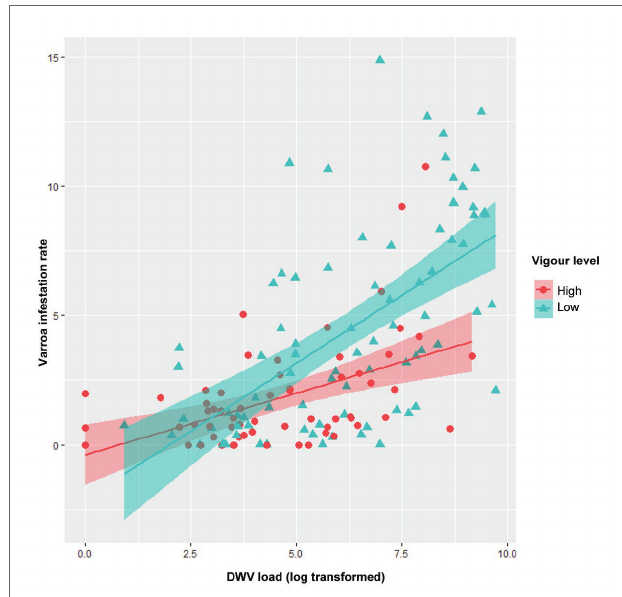
FIGURE 2 | Scatter plot showing correlation of DWV load and varroa infestation rate. Low-vigor colonies are shown in blue; high-vigor colonies, red. Regression lines and confident bands are also shown.